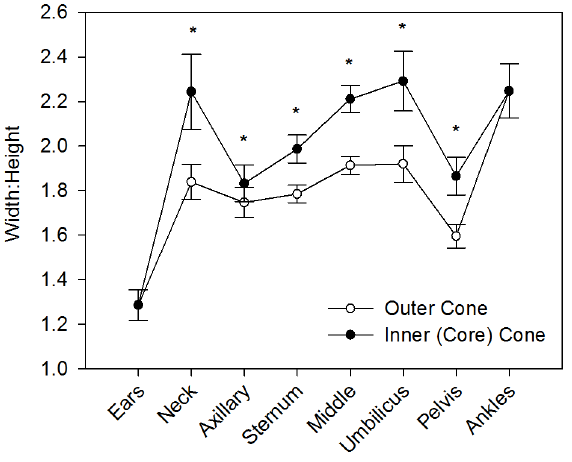
Figure 3. Weddell seal body cross-sections are elliptical. Mean 6 SE width-to-height ratios along the body of adult female Weddell seals ( N =11), with a circle having a ratio=1. Asterisk indicates that the width-to-height ratio of the inner core cone is significantly greater than the outer, total body cone.